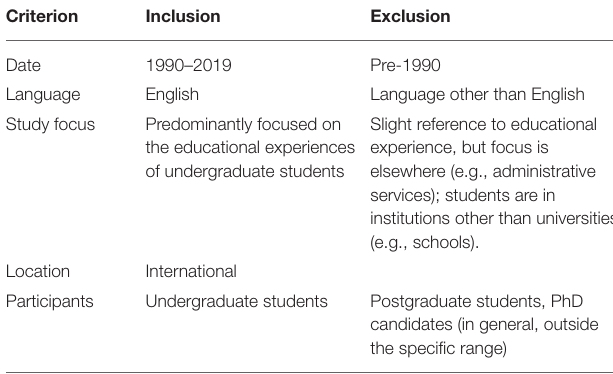
TABLE 2 | Inclusion and exclusion